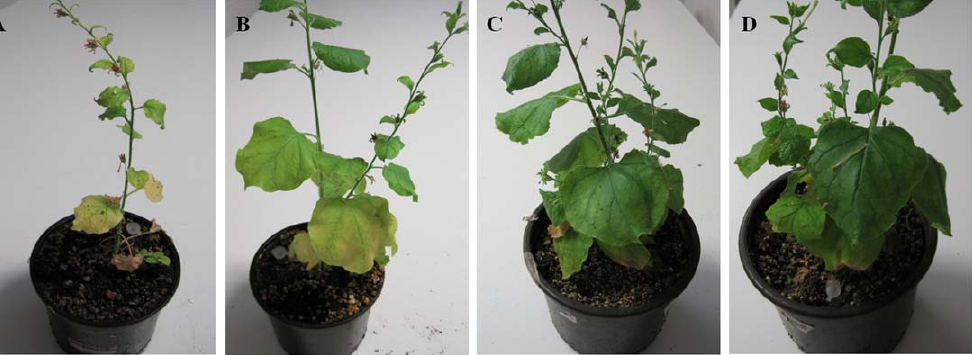
Figure 4. Symptoms of Beetnecroticyellowveinvirus in N.benthamiana at 30 days post inoculation. A) Non-transgenic plant. B) T2 transgenic plant expressing fragment of the BNYVV-replicase gene. C) T2 transgenic plant expressing the hrpZ Psph transgene. D) T2 double transgenic plant expressing the hrpZ Psph and a fragment of the BNYVV-replicase gene. The transgenic plant expressing the hrpZ Psph as well as the double transgenic plant, expressing both the hrpZ Psph and the BNYVV-replicase transgene, are symptomless. In contrast, the BNYVV dsRNA-expressing plant and the non-transgenic control plant exhibit symptoms of general stunting and/or leaf curling. doi:10.1371/journal.pone.0051414.g004 PLOS ONE |